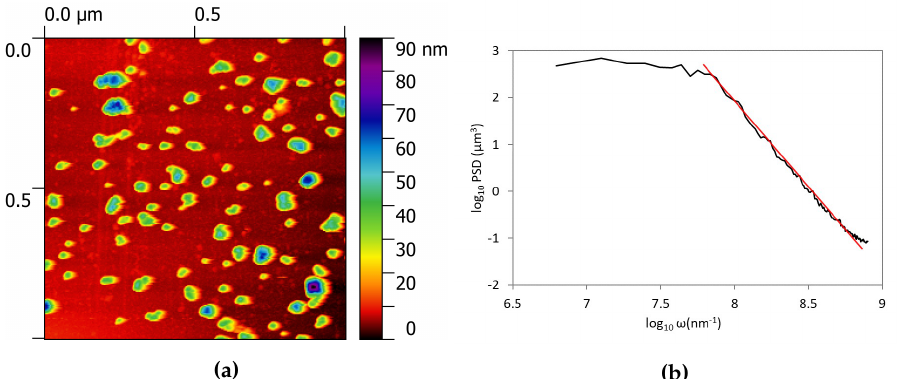
Figure 3. Surface data on a 1 × 1 µ m zone. ( a ) is the AFM image and ( b ) is the power spectral density function evaluated in the same